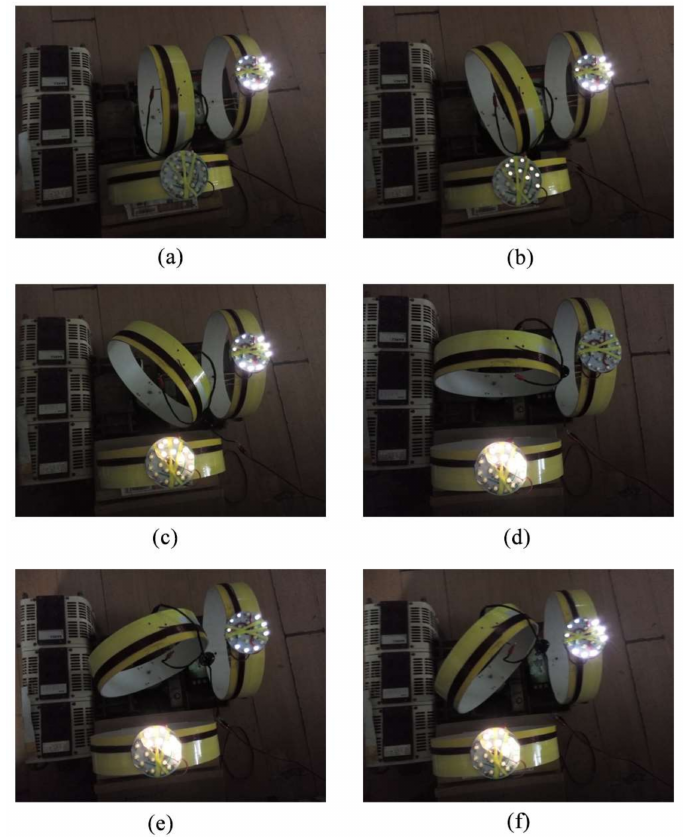
Figure 15. Brightness variation of the two sets of LEDs in the dual-receiver system: ( a ) θ = 0; ( b ) θ = π /6; ( c ) θ = π /4; ( d ) θ = π /2; ( e ) θ = 2 π /3; and ( f ) θ = 3 π